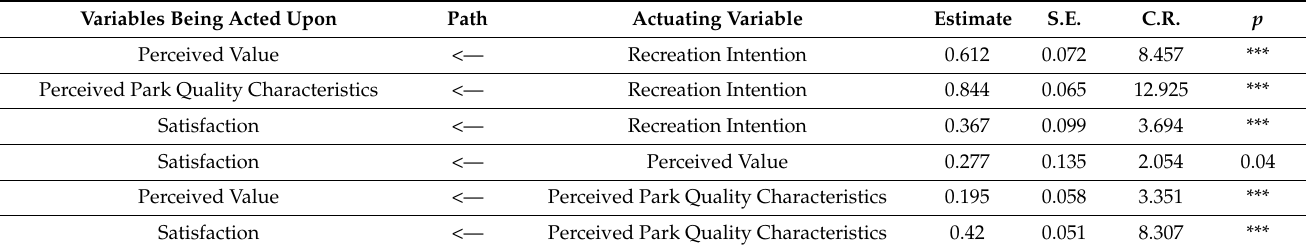
Table 4. Significance analysis of the